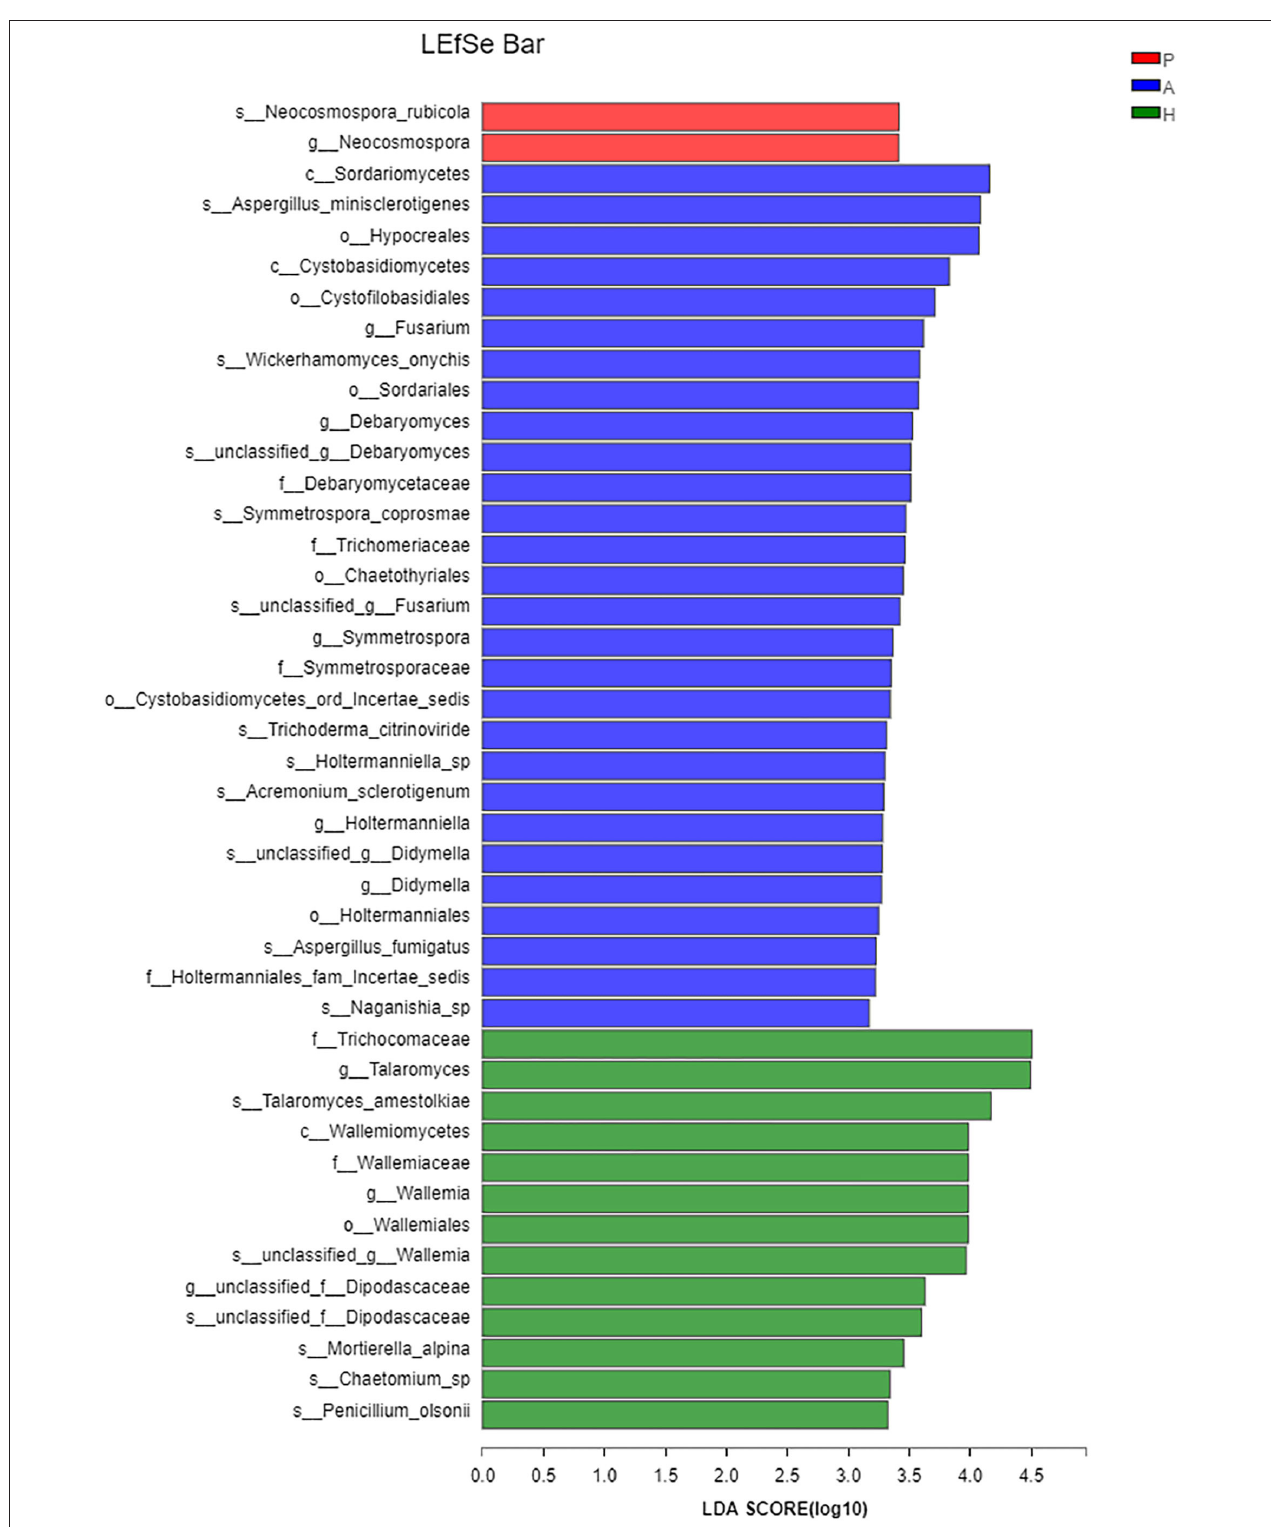
FIGURE 13 | Linear discriminant analysis of effect sizes (LEfSe) barplot of fungal flora. Linear discrimination analysis (LDA) was used to estimate the effect of abundance of each component on the differential effect.